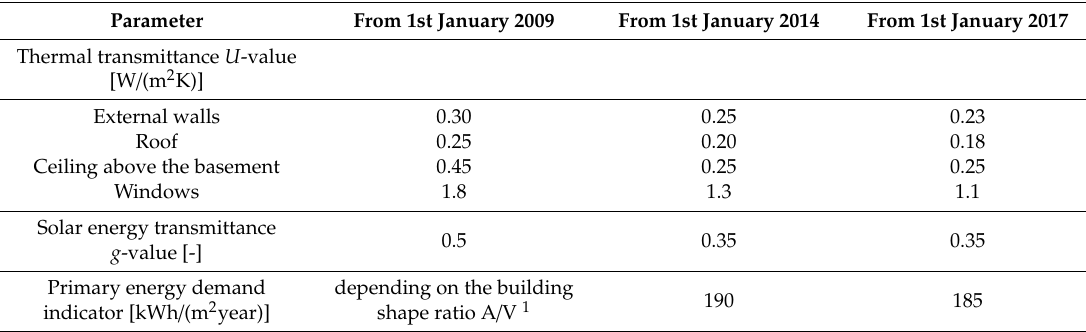
Table 1. Changes in Polish technical